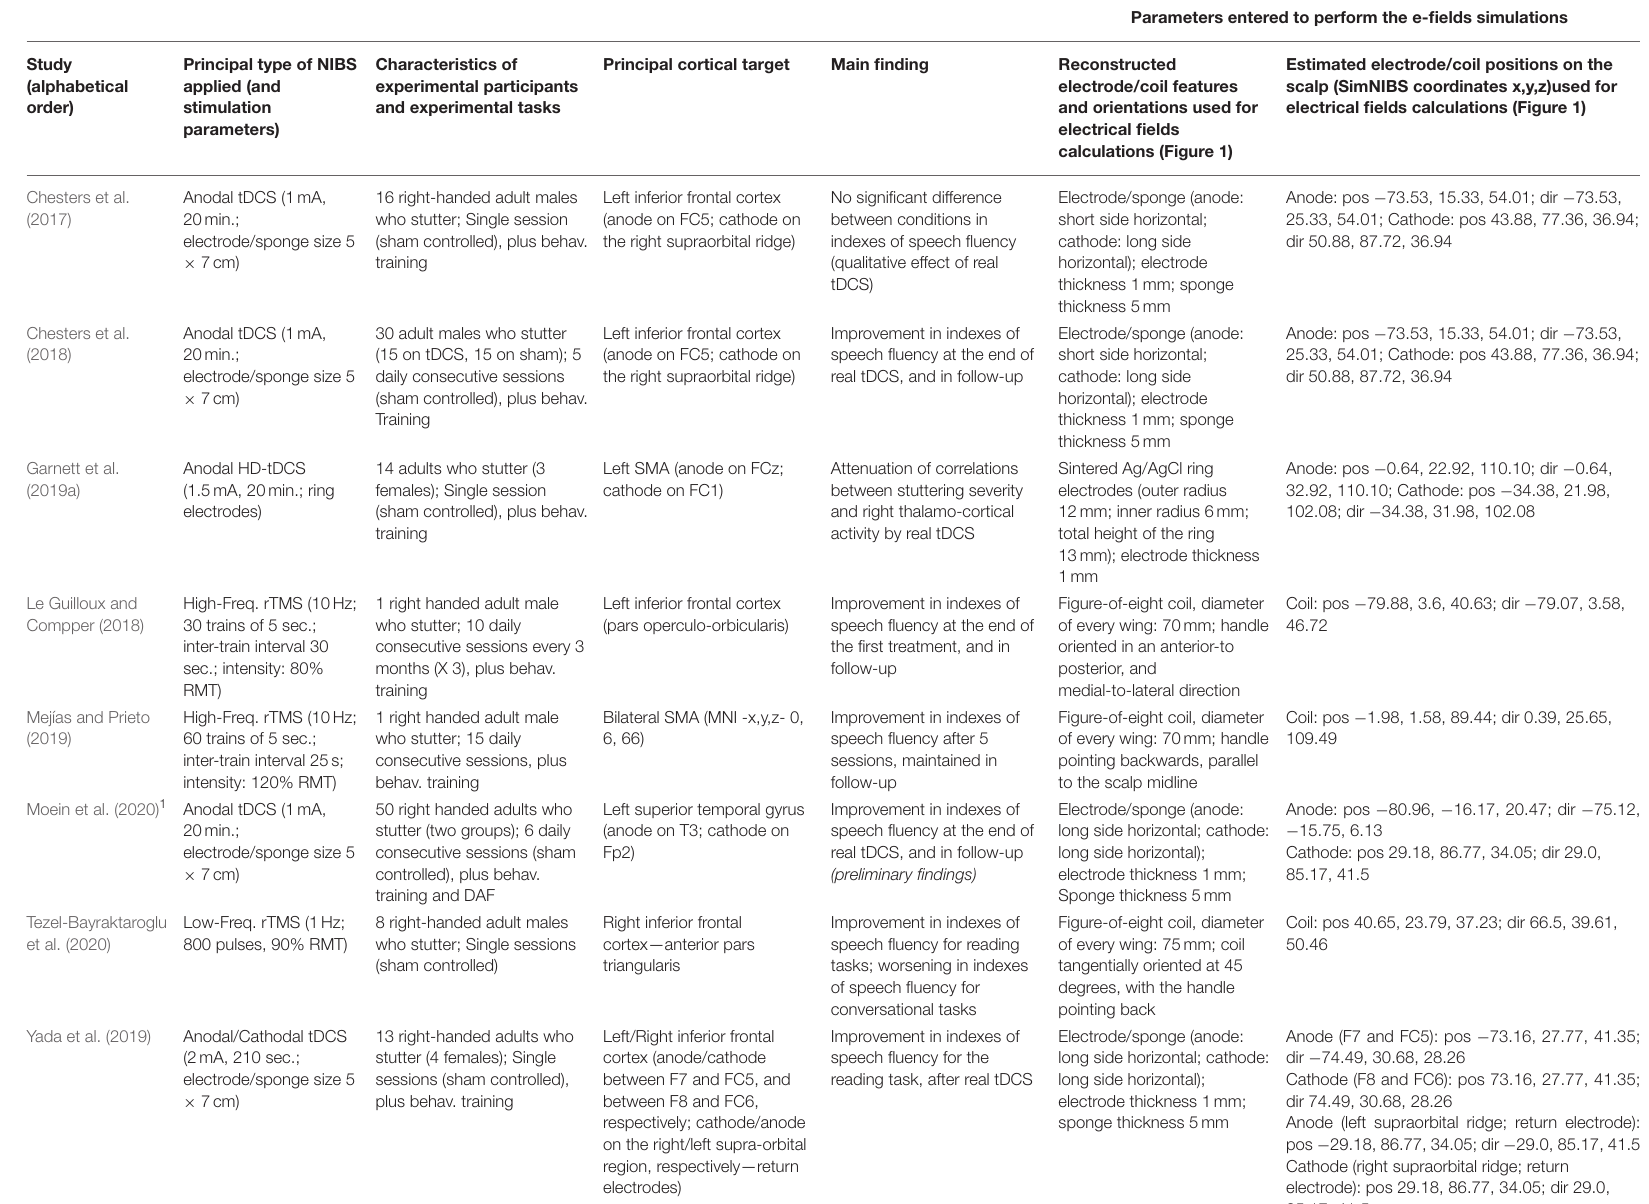
TABLE 1 | Summary of characteristics and findings of the reviewed studies using non-invasive brain stimulation (NIBS) neuromodulation in developmental stuttering (DS) to improve speech fluency.